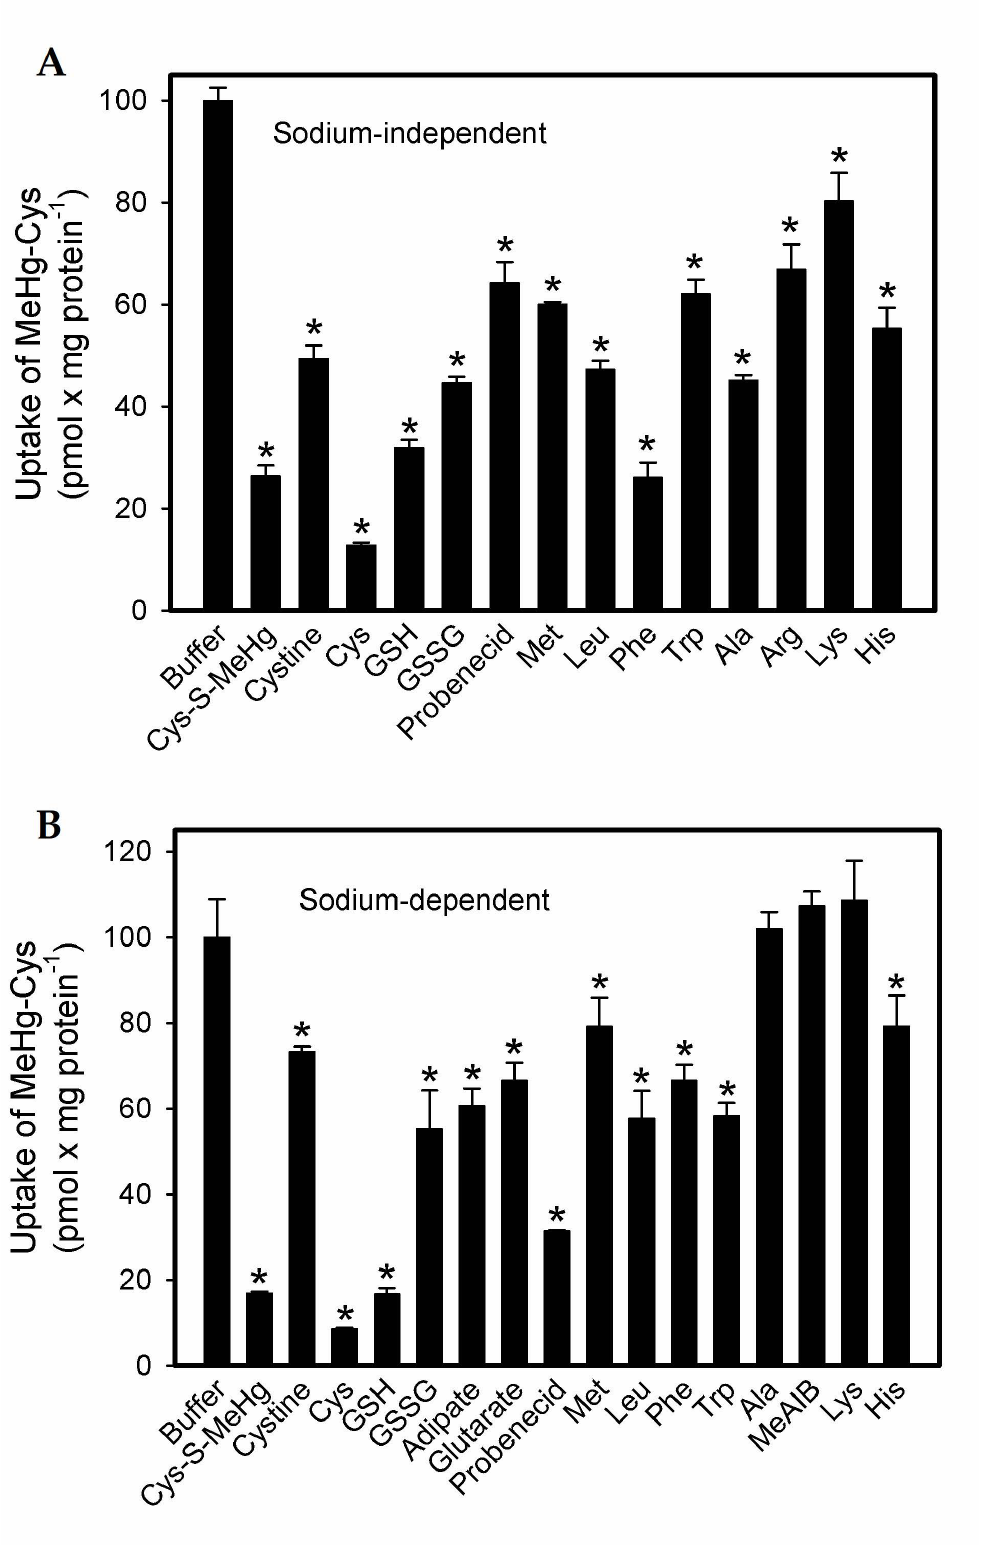
Figure 3. Substrate specificity analyses of [ 14 C]-MeHg-Cys transport in BeWo cells. Cells were incubated for 30 min at 37 ◦ C with [ 14 C]-MeHg-Cys in the presence of various unlabeled com- pounds (1 mM Cys-MeHg and cystine; 3 mM all others) under sodium-independent ( A ) and sodium- dependent ( B ) conditions. Results are presented as mean ± SE. Data represent 3 experiments performed in triplicate. *, significantly different ( p < 0.05) from cells exposed to buffer